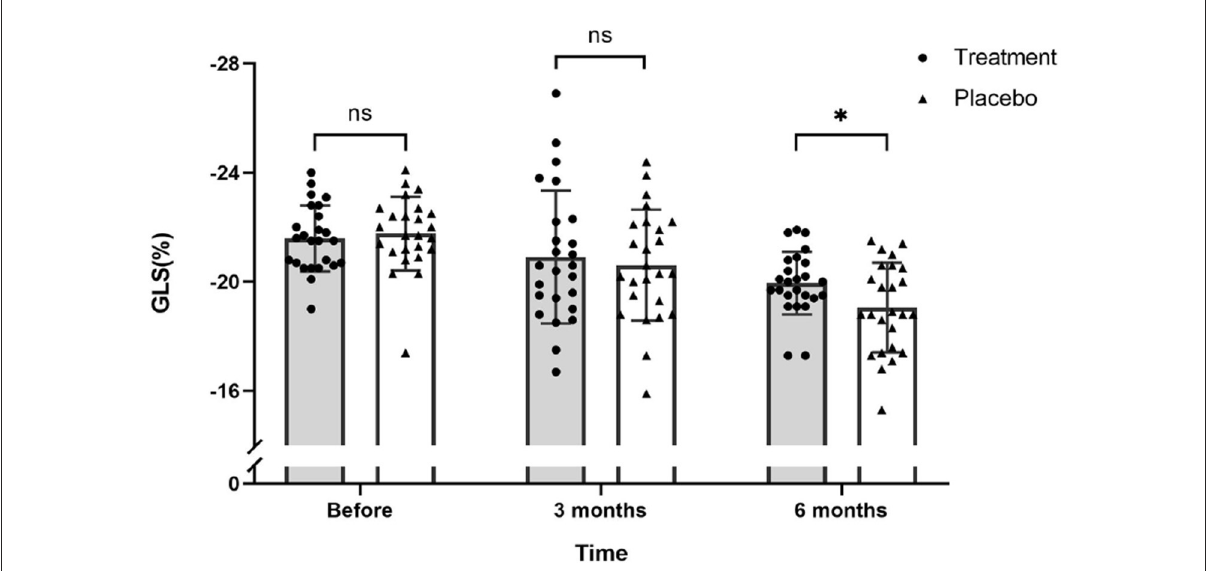
FIGURE4 Scatter plot for GLS values of 51 patients on the day before chemotherapy, 3 months after the first round of chemotherapy and 6 months after the first round of chemotherapy. There was no significant difference in GLS values between the treatment and placebo groups before and after 3 months of chemotherapy. After 6 months of chemotherapy, the GLS values of the treatment group was significantly higher than the placebo group (ns, not significant; * P ≤